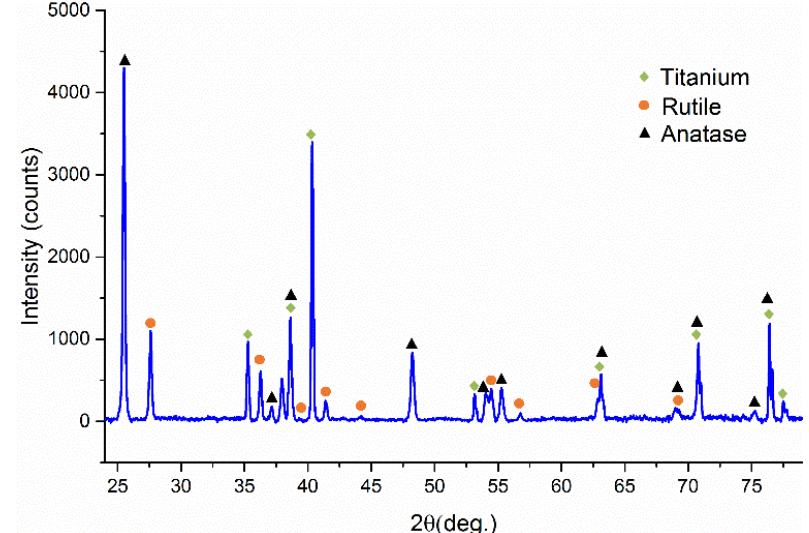
Figure 14. XRD analysis result for PEO-treated sample for 4 min.